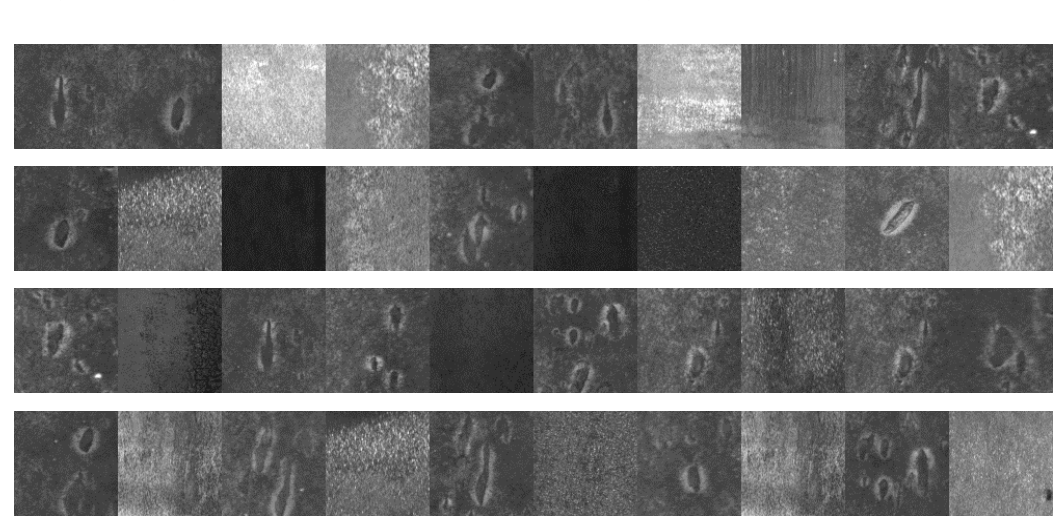
Figure 4. Positive samples of simulated periodic defects.